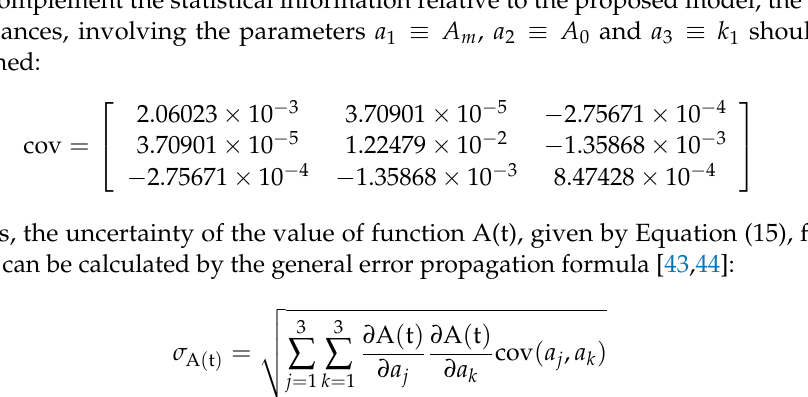
Figure 5. Curve of L. salivarius growth in the filmogenic solution represented by the proposed model.